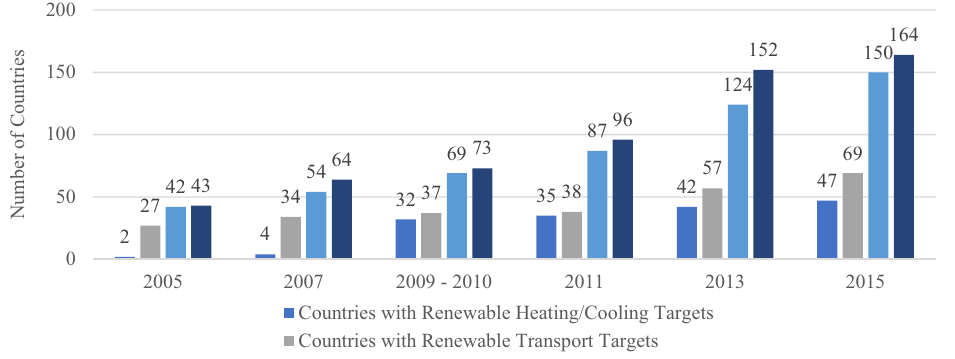
Figure 19: Countries with renewable energy targets. ( Retrieved from the Resource IRENA website: resourceirena.irena.org/gateway/. )